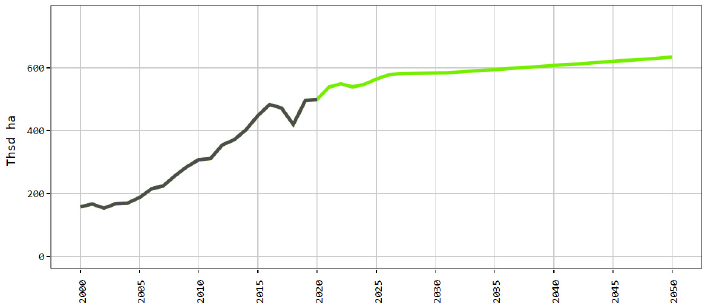
Figure 9. Wheat area in 2000–2020, with a 2021–2050 projection for Latvia, in thousands of hectares [62].